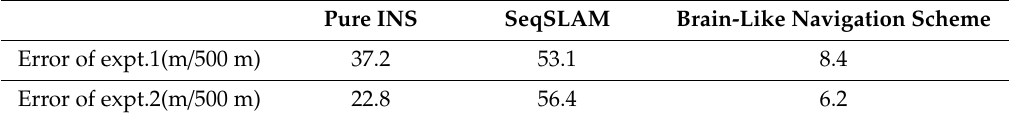
Table 7. Distance